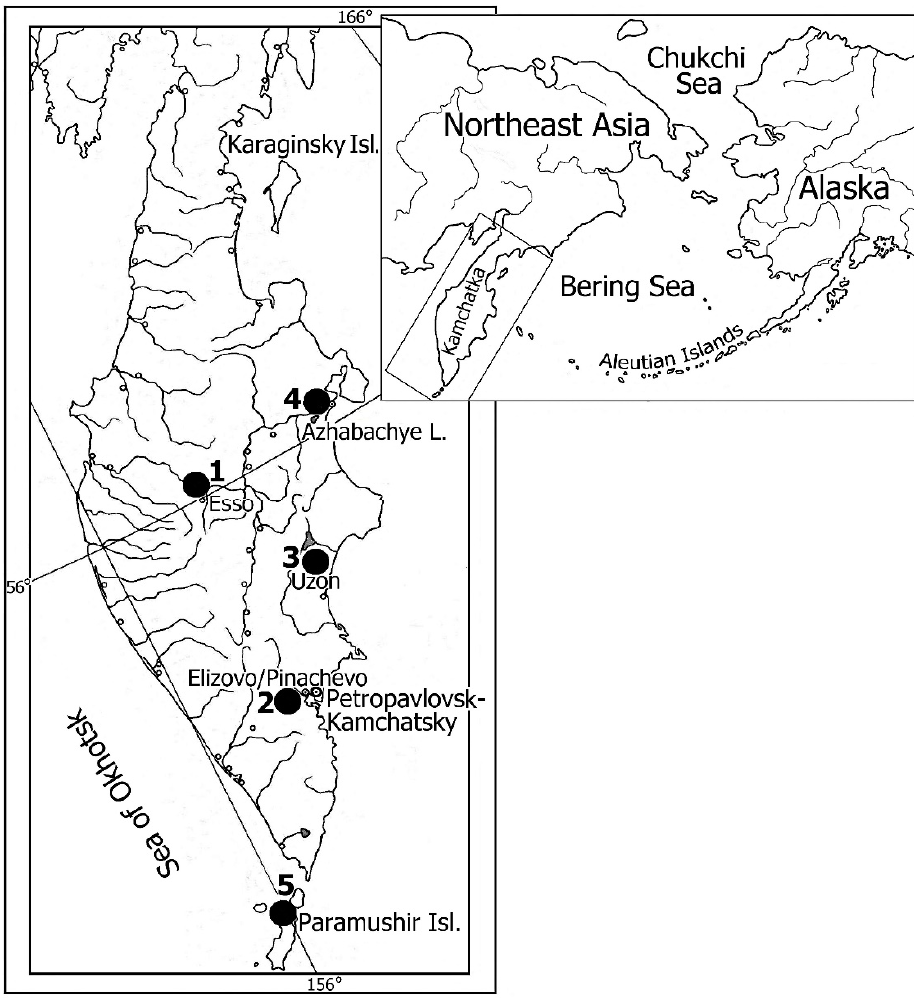
Figure 1. Collection sites of shrew cestodes on Kamchatka and Paramushir Island: 1—Esso,